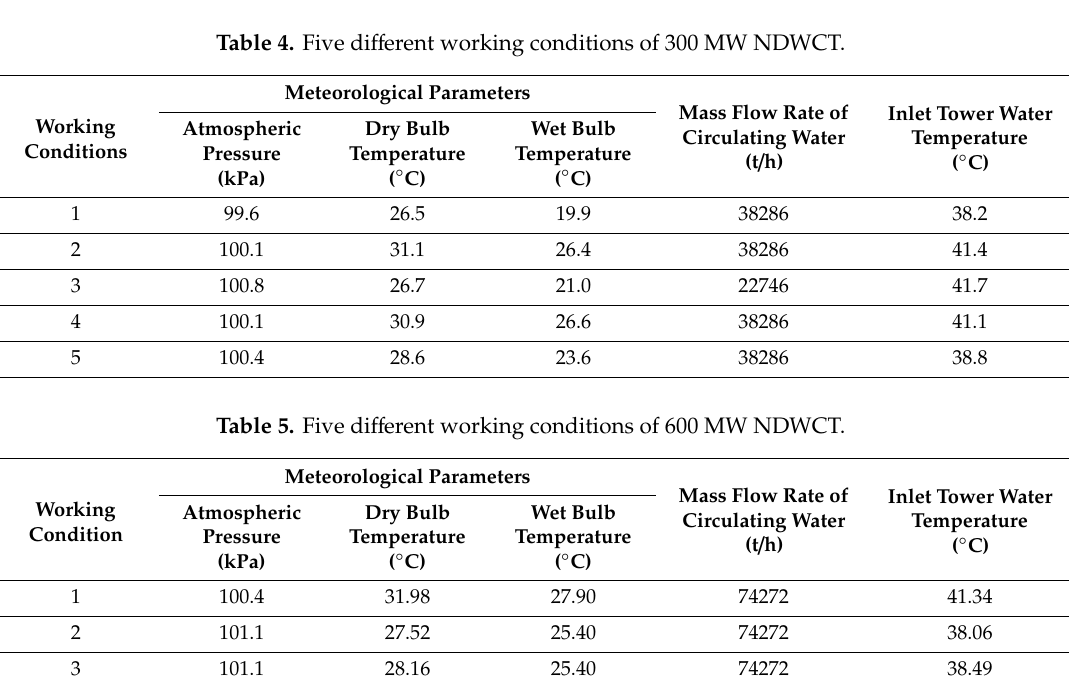
Figure 5. Schematic diagram of experimental data acquisition. Table 2. Geometric dimensions of the NDWCT.